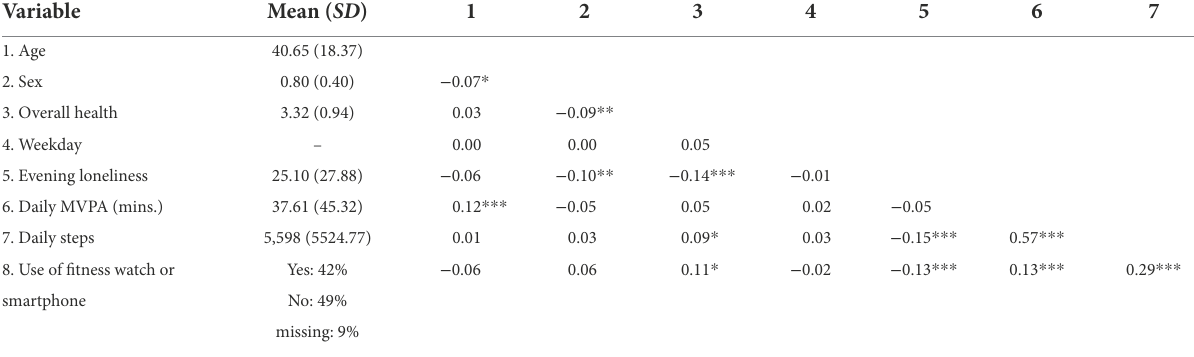
TABLE 1 Means, standard deviations, and intercorrelations of central study variables ( N = 139).